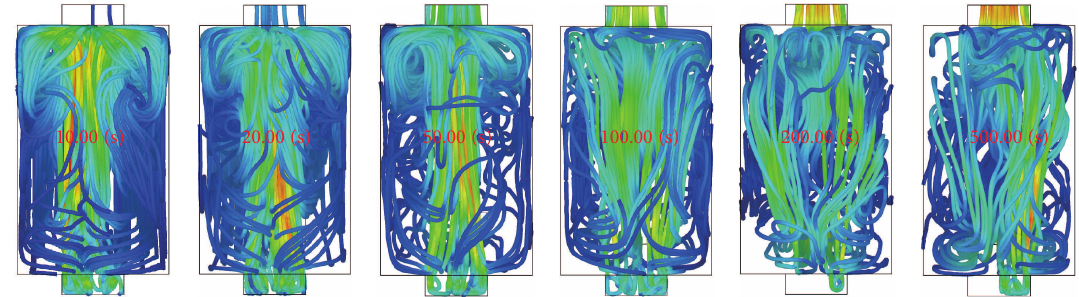
Figure 9: Streamline (right